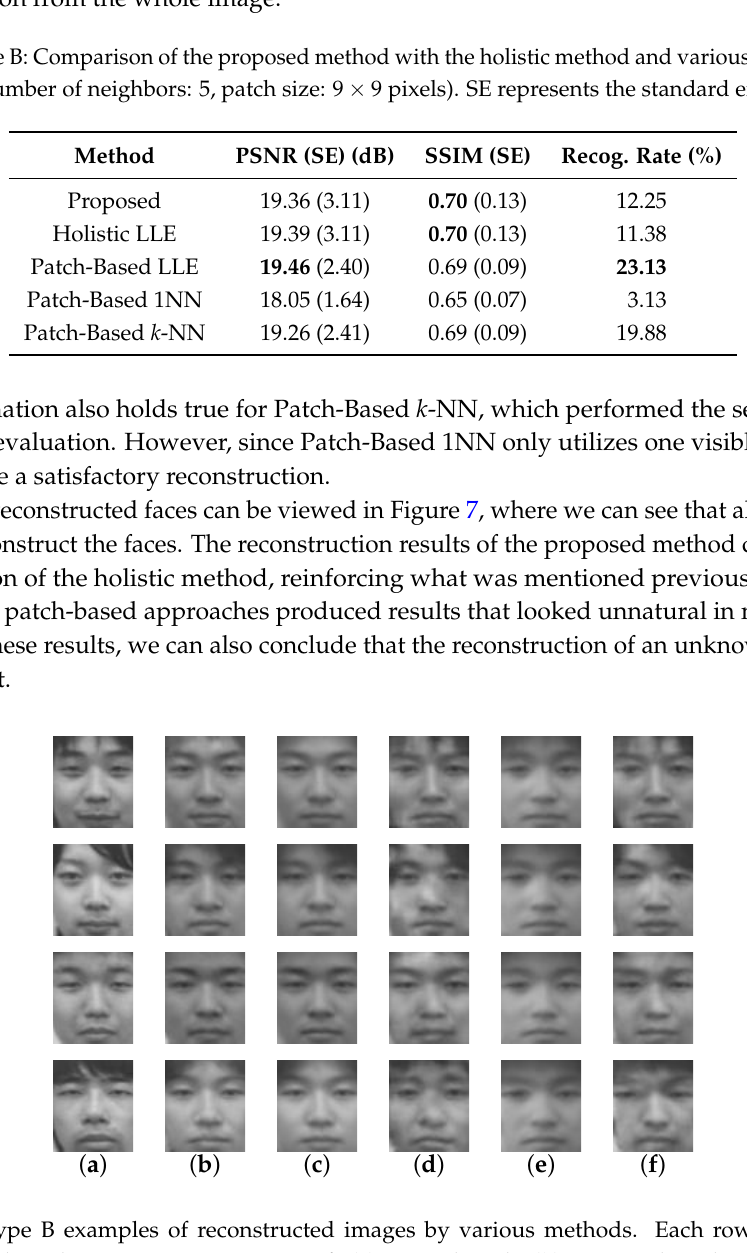
Figure 7. Type B examples of reconstructed images by various methods. Each row indicates a person and the columns represent images of: ( a ) ground-truth; ( b ) proposed method; ( c ) holistic LLE; ( d ) patch-Based LLE; ( e ) patch-Based 1NN; ( f ) patch-Based k